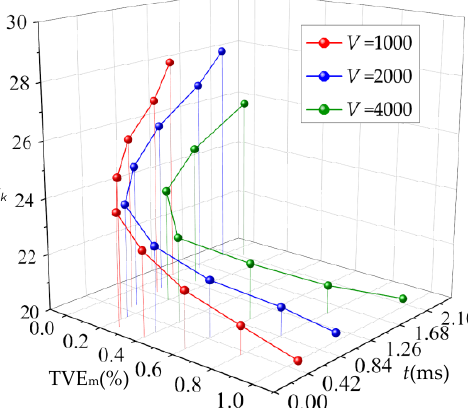
Figure 2. Comparison of operating effects under different conditions. The running results are shown in Figure 3.